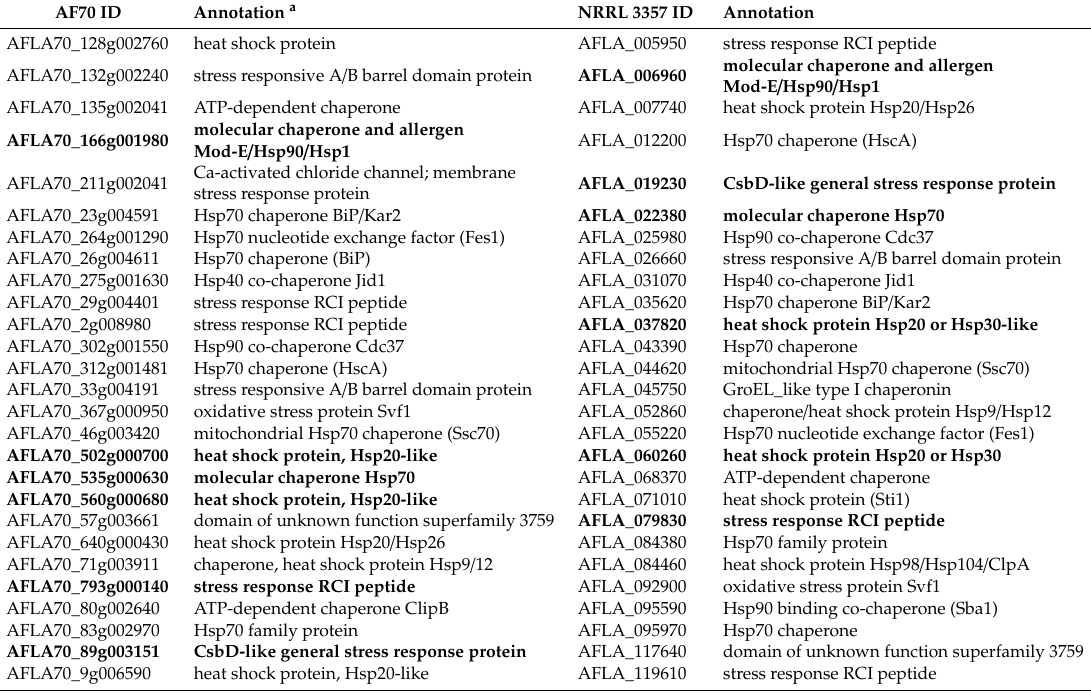
Table 6. Putative descriptions of stress-related A. flavus AF70 and NRRL 3357 genes.